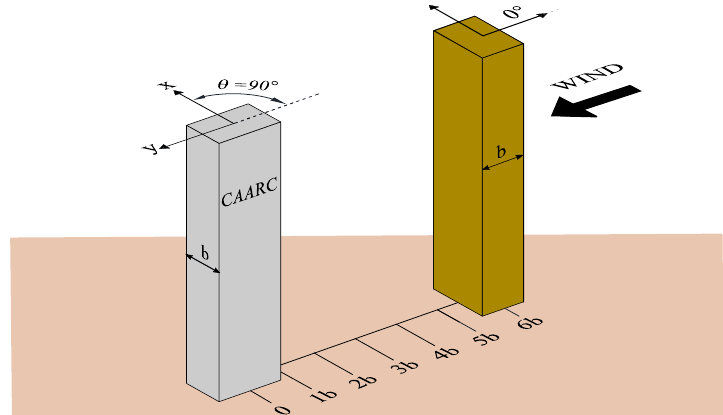
Figure 4. Three-dimensional view example with CAARC orientation angle θ = 90° and neighbor at position 6b at